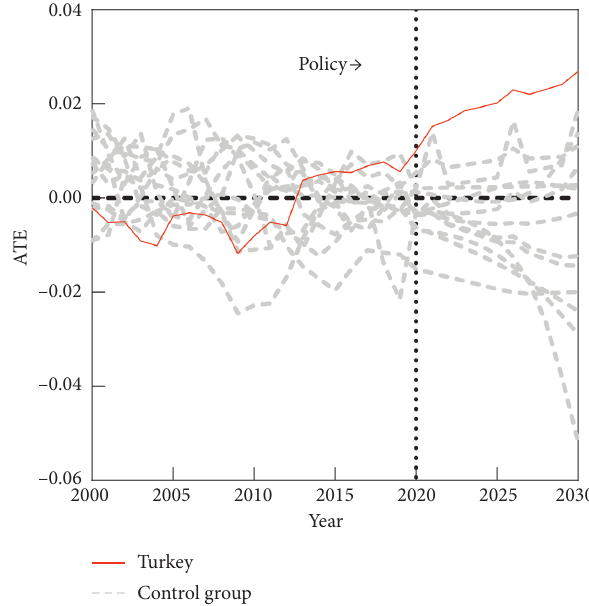
Figure 7: Placebo test of policy effect of Turkey’s higher education development